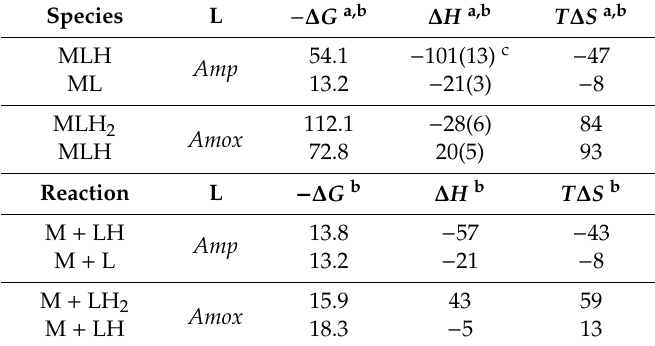
Table 4. Thermodynamic formation parameters for Mn 2 + - Amp , Mn 2 + - Amox species at t = 25 ◦ C and I = 0.15 mol L − 1